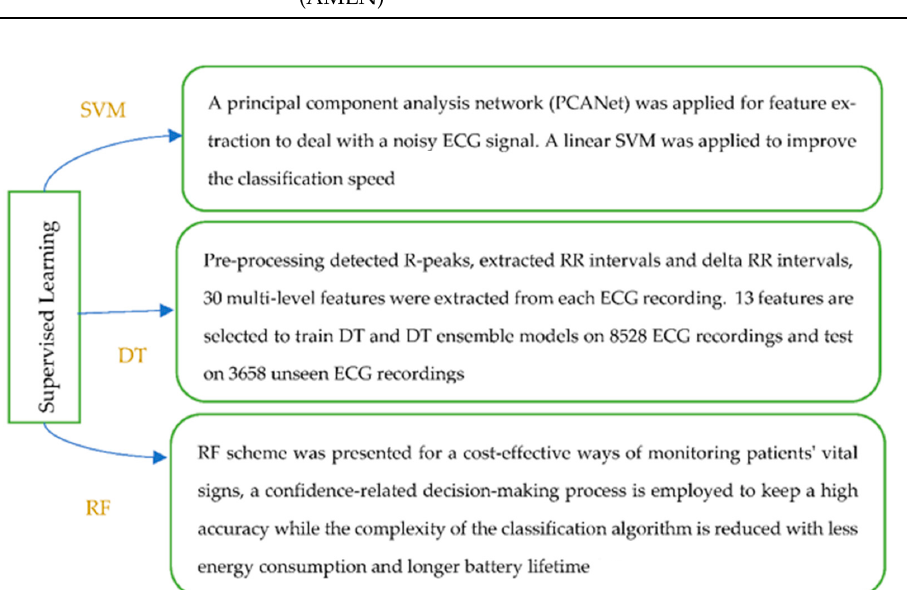
Figure 5. Supervised Machine Learning methods [20,28,38].